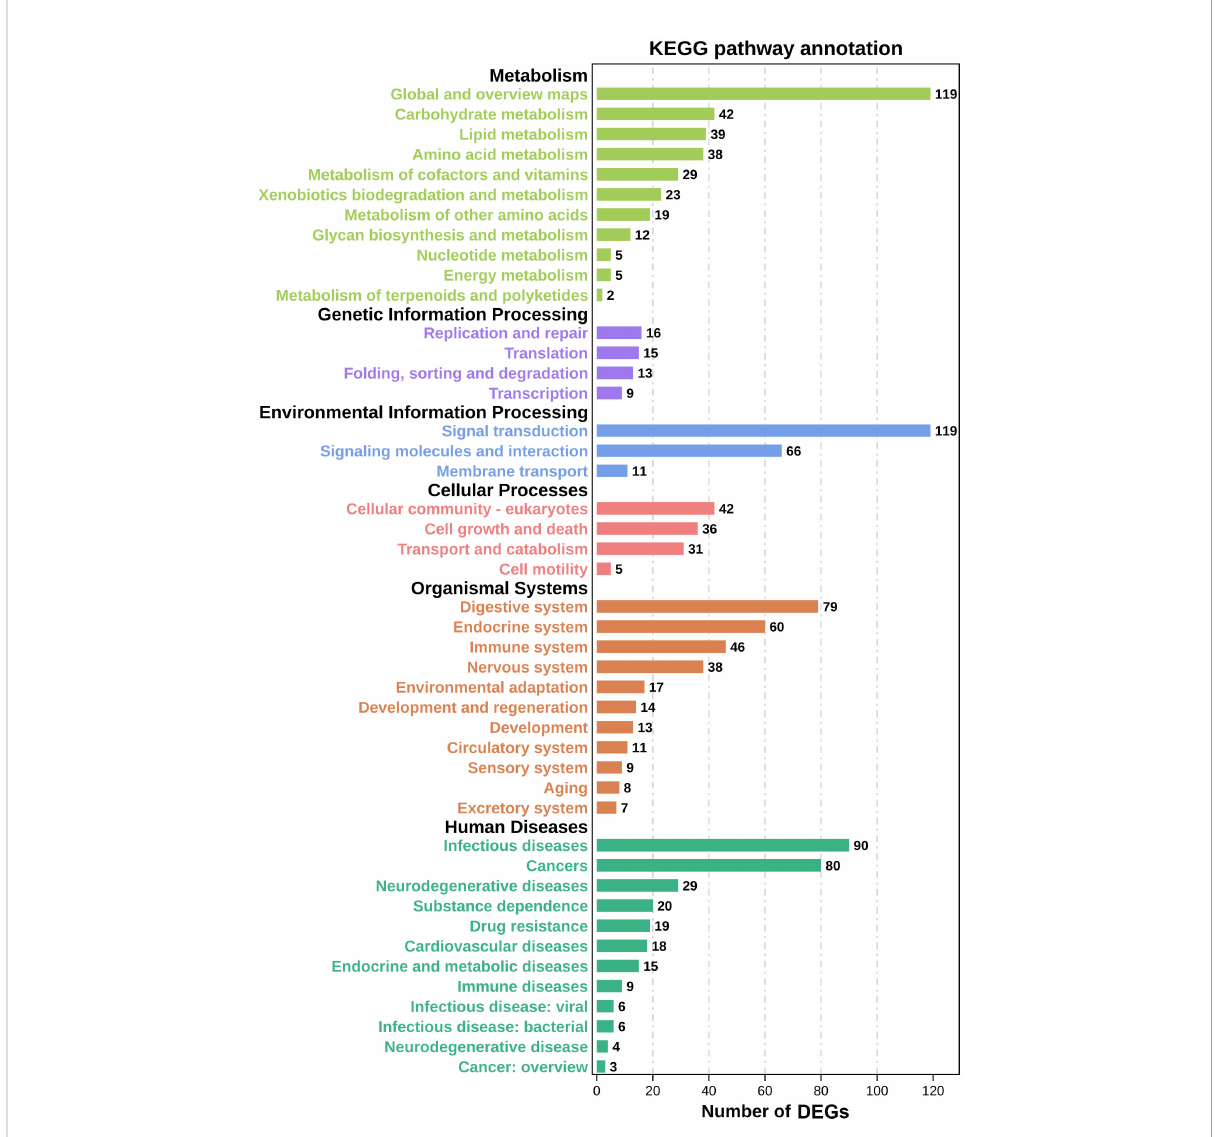
FIGURE 5 Level-2 KEGG signaling pathways results. The abscissa represents the number of DEGs in the pathway; the ordinate indicates the speci fi c name of these